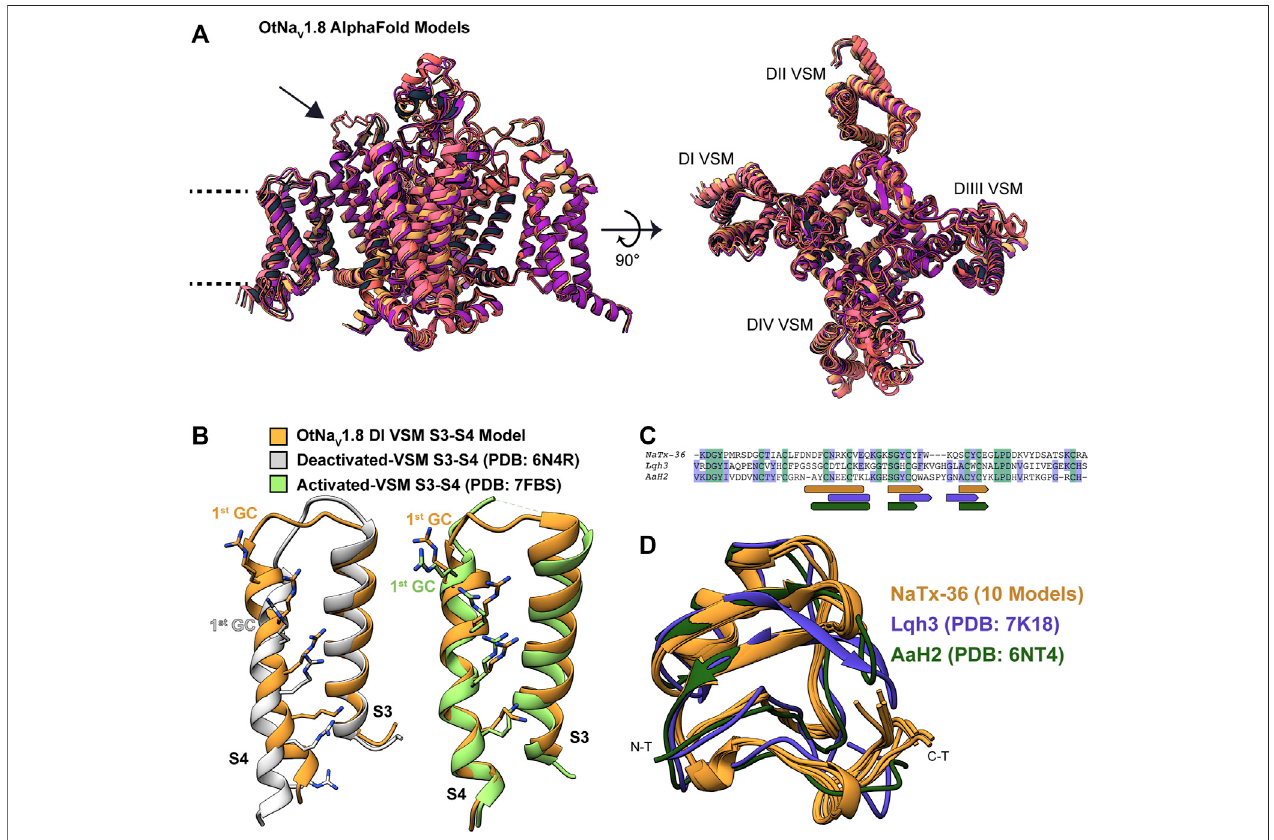
FIGURE 11| Computational modeling of OtNa V 1.8 and NaTx36 structures. (A) Representative ribbon structures for the fi ve top models of OtNa V 1.8 generated by AlphaFold;dashedlinesrepresentapproximatemembraneboundaries,andtheblackarrowpointstotheDIIS5 – SS1loop. (B) Positionofgatingcharges(GC)withinthe DI voltage sensor S4 segment of the OtNa V 1.8 model. DI S3 – S4 segments from the OtNa V 1.8 model are compared with experimental structures of activated and deactivated voltage sensor segments to illustrate that the OtNa V 1.8 DI S3 – S4 was modelled in the activated (outward) state. In the activated state, the fi rst GC R215 is exposed to the extracellular solvent. (C) Sequence alignment of NaTx36 with two other scorpion toxins, Lqh3 and AaH2, whose biological actions on voltage- gated sodium channels are well-described; rounded rectangles indicate sequence segments corresponding to alpha-helices, and pentagons indicate beta strands. (D) NaTx36 models generated by AlphaFold and RosettaFold are superimposed onto the experimental structures of scorpion toxins Lqh3 and AaH2.